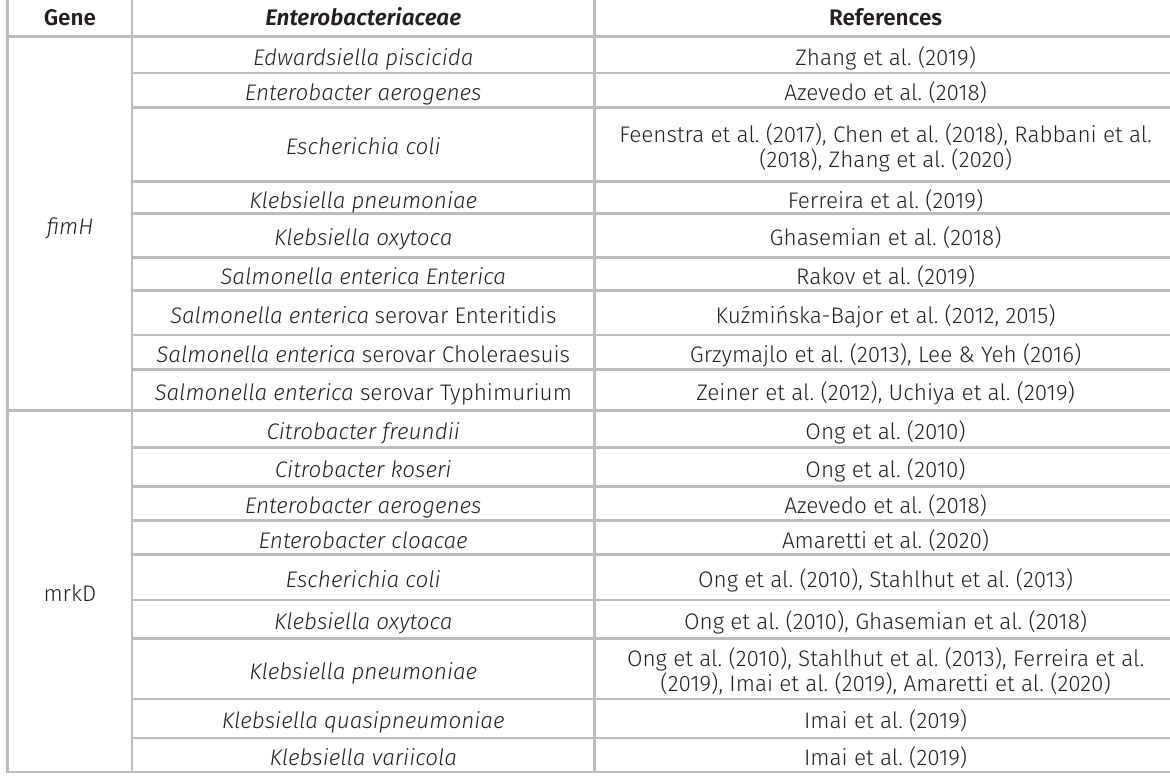
Table II. Detection of fimH and mrkD genes in species from Enterobacteriaceae family.